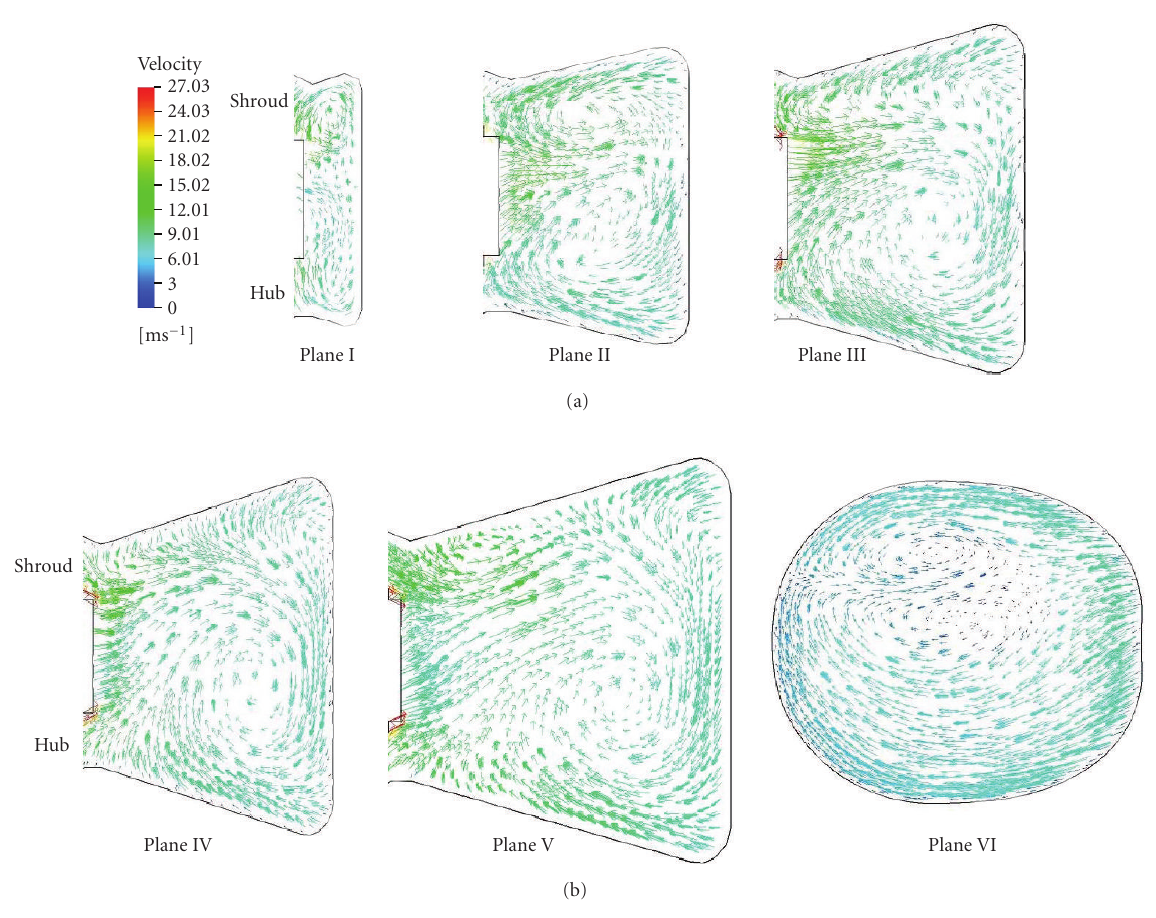
Figure 6: Unsteady flow developed inside the volute casing at various